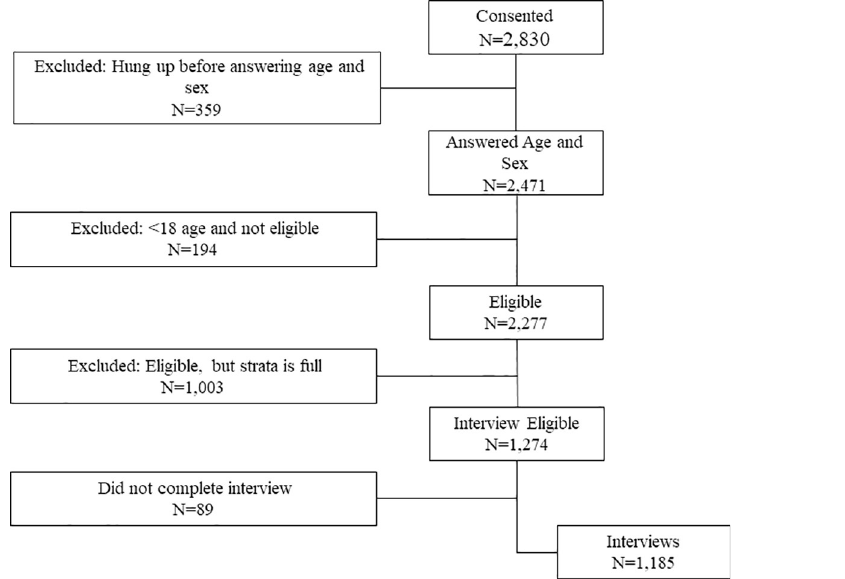
Fig 3. Ecuador COVID-19 mobile phone survey data